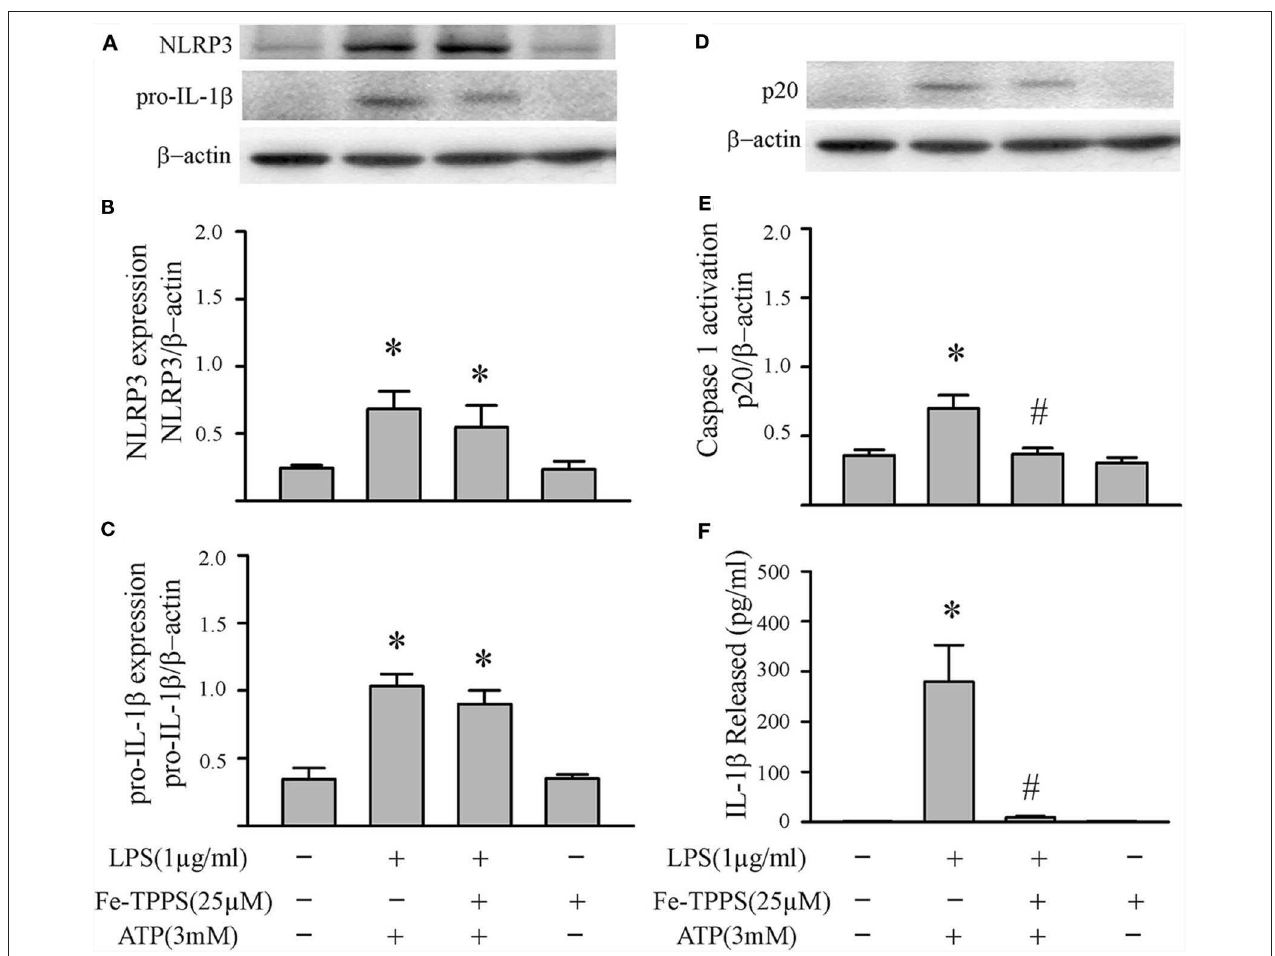
FIGURE 9 | A peroxynitrite decomposition catalyst (Fe-TPPS) decreases ATP-induced activation of the NLRP3 inflammasome. Fibroblasts were challenged with LPS (1 µ g/mL) for 6h. Subsequently, the fibroblasts were treated with Fe-TPPS (25 µ M) or vehicle for 15min, followed by ATP (3mM) for an additional 30min. (A–C) NLRP3 and pro-IL-1 β protein levels were indices of inflammasome priming. Representative Western blots are shown in (A) and densitometric analyses in (B,C) . Of note, NLRP3 and pro-IL-1 β were increased after the initial LPS challenge, but the subsequent challenge with ATP was without effect on these two indices of inflammasome priming. (D–F) Caspase1 activation (p20) and IL-1 β protein levels in the supernatant were indices of inflammasome activation. Representative Western blot for caspase1 p20 is shown in (D) and densitometric analysis in (E) . Protein levels of IL-1 β were assessed in supernatants by ELISA. n = 3, * p < 0.05 as compared with control; # p < 0.05 as compared with LPS +